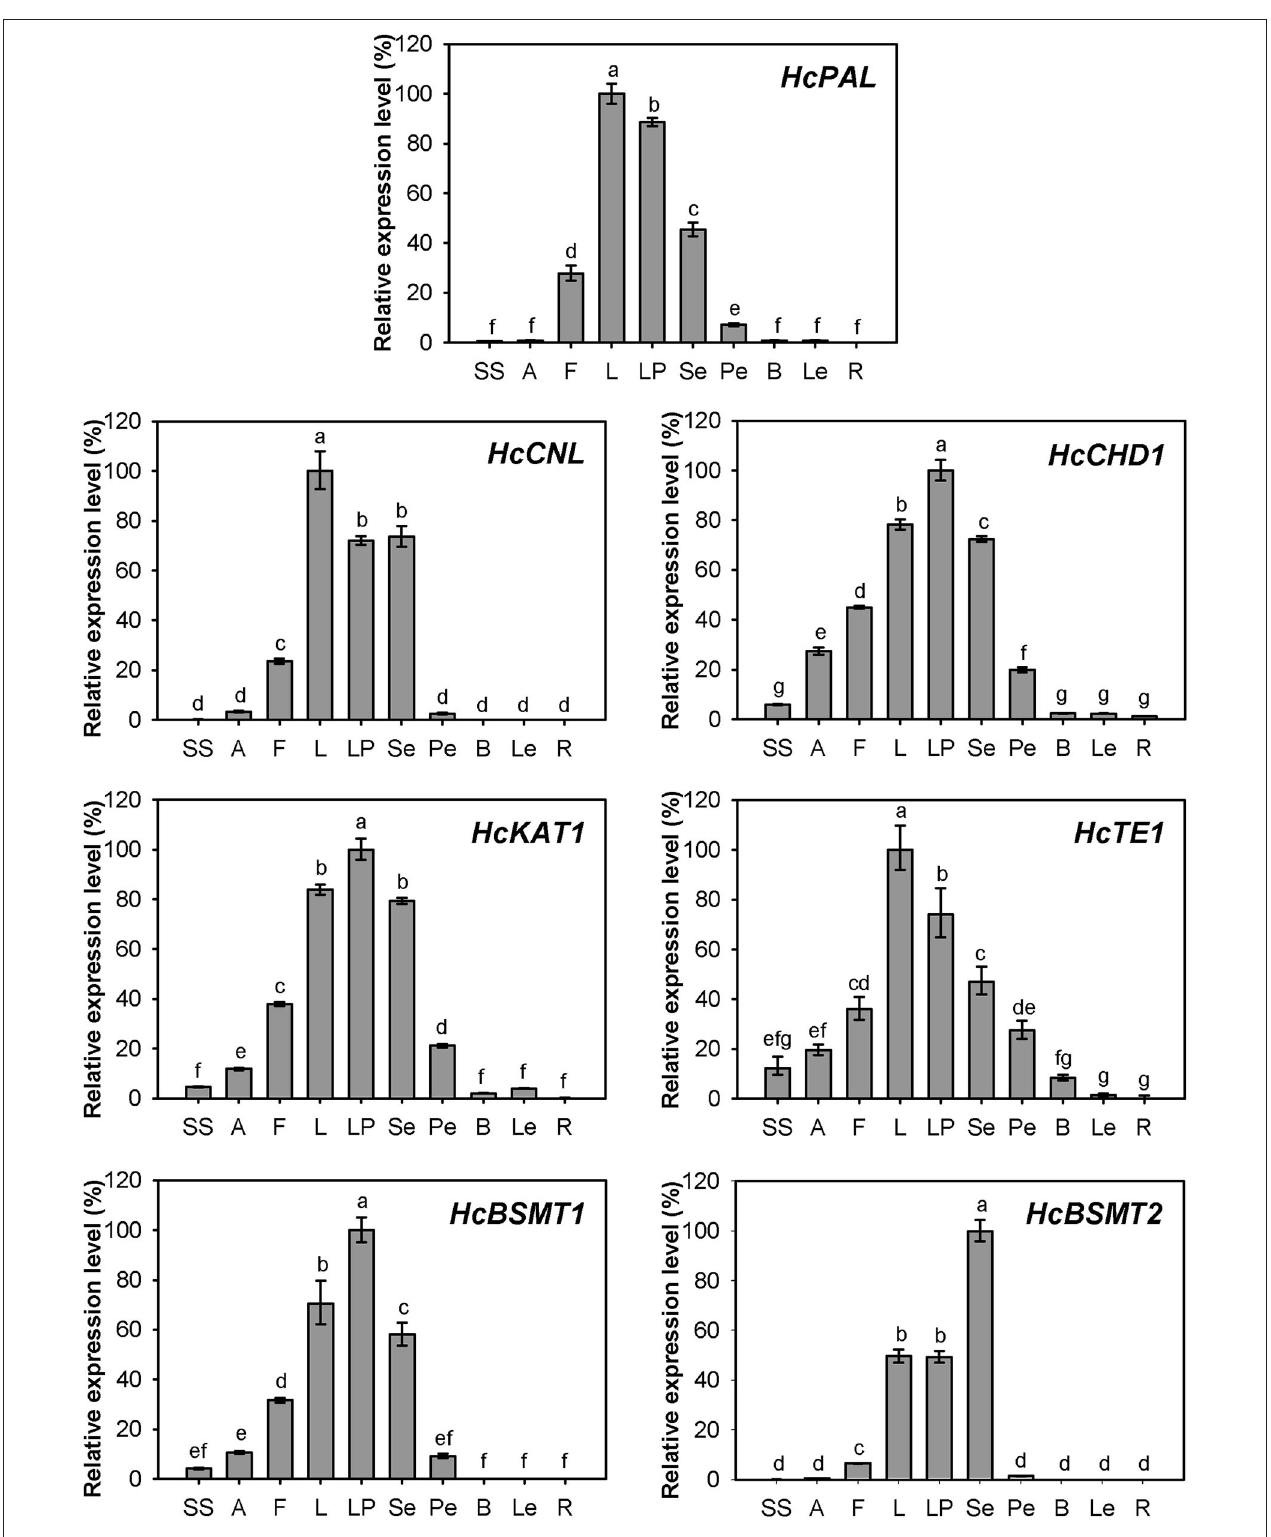
FIGURE 7 | Expression analysis of genes related to methyl benzoate biosynthesis in different tissues. Relative transcription level of tissue with highest expression quantity was set to 1 (100%). Error bars indicate the calculated maximum and minimum expression quantity of three replicates. Different lowercase letters labeled on bars indicate statistically significant differences at the level of P < 0.05. SS, styles and stigmas; A, anthers; F, filaments; L, labella; LP, lateral petals; Se, sepals; Pe, pedicels; B, bracts; Le, leaves; R, rhizomes.